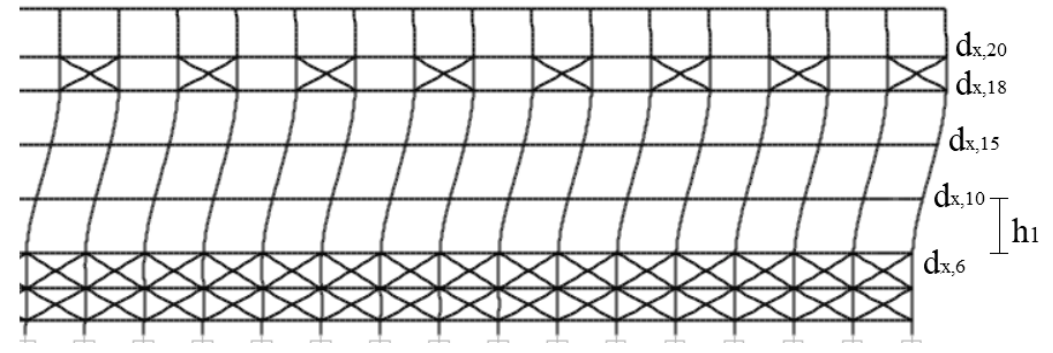
Figure 11. Assumption for the interstory drift evaluation.